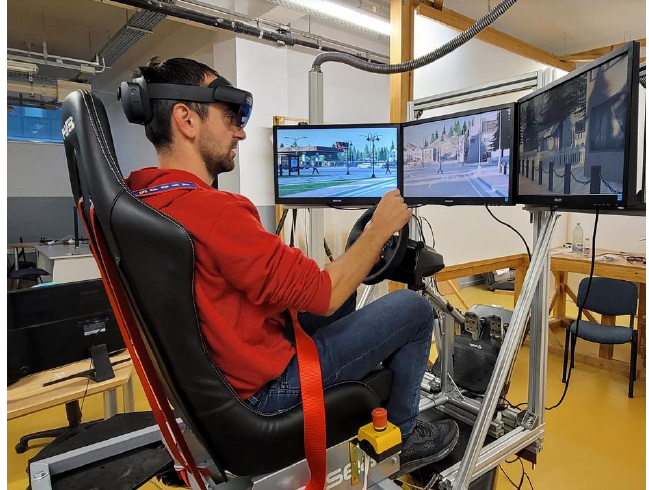
Figure 2. Driving simulator.